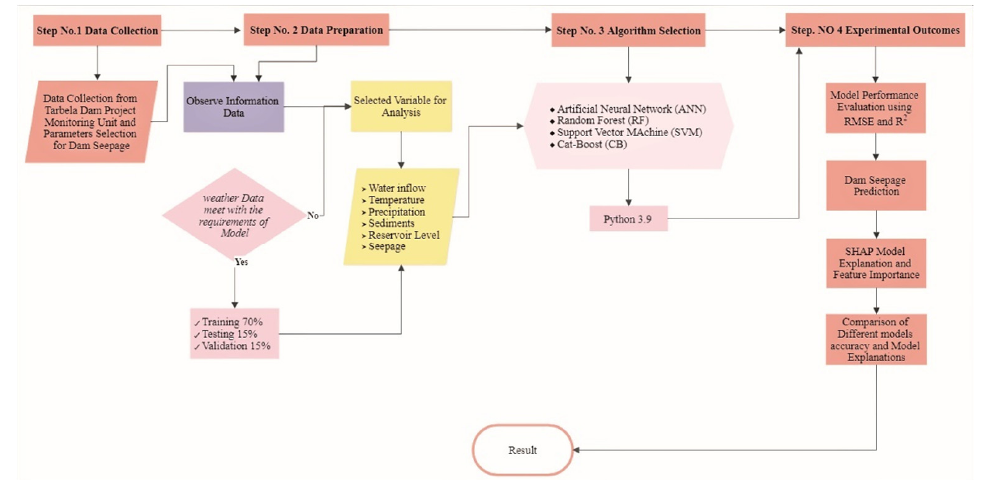
Figure 2. Research flow chart for Machine Learning Models. Table 1. Input variable for Machine Learning Model. S.